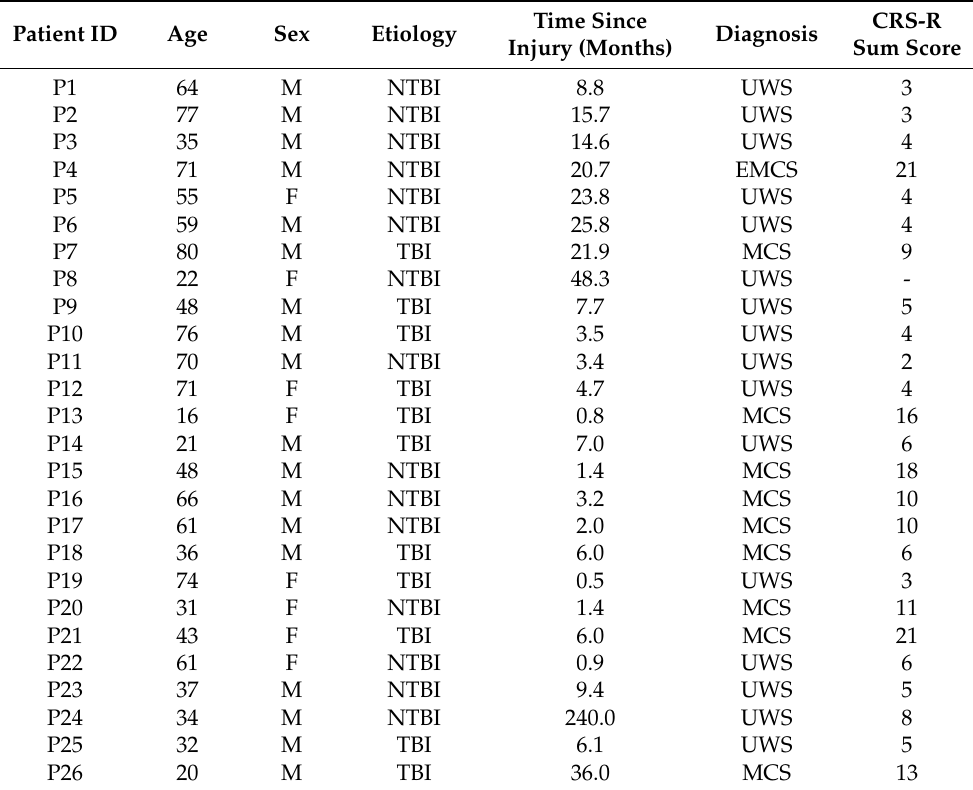
Table 1. Demographic information and highest CRS-R sum